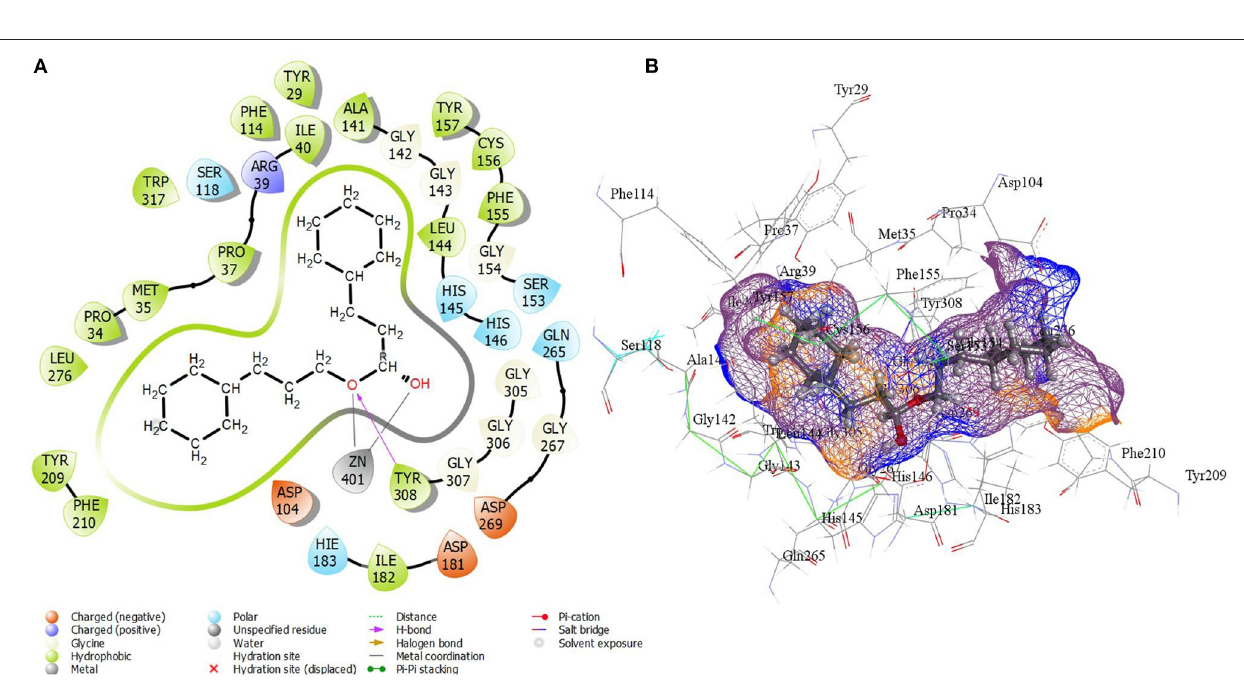
Frontiers in Nutrition |